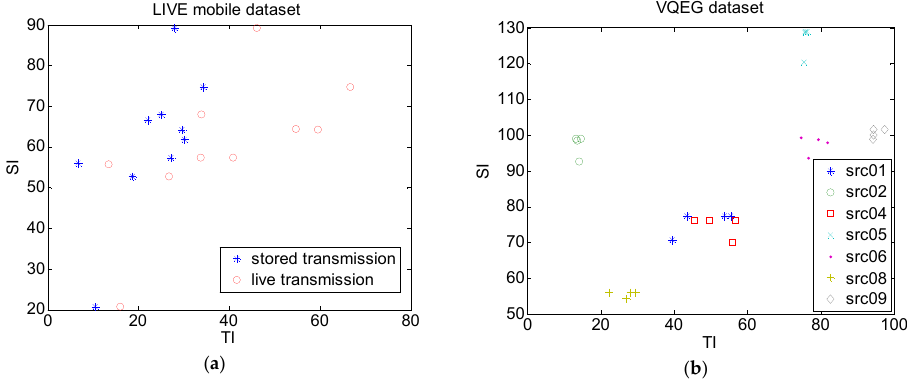
Figure 3. Temporal information versus spatial information (SI H,V ) for: ( a ) LIVE mobile dataset, stored transmission scenario (blue) and live transmission scenario (red); ( b ) VQEG dataset (video sequences src01, src02, src04, src05, src06, src08, and src09 with degradations hrc10, hrc11, hrc12, and hrc15, previously described).